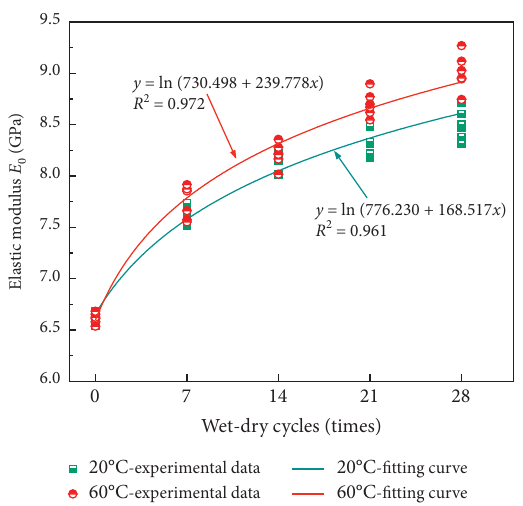
Figure 9: Elastic modulus of RC after being subjected to different wet-dry